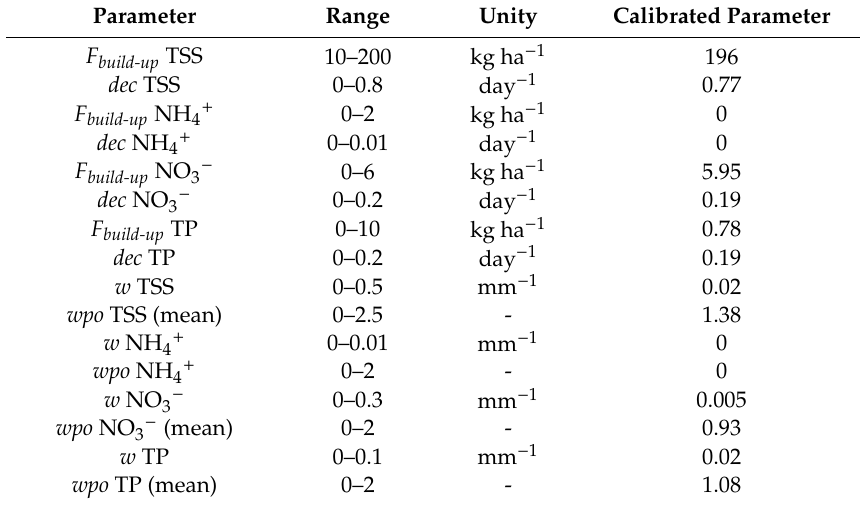
Table A1. Range of parameter values used in the calibration runo ff water quality and parameter calibrated